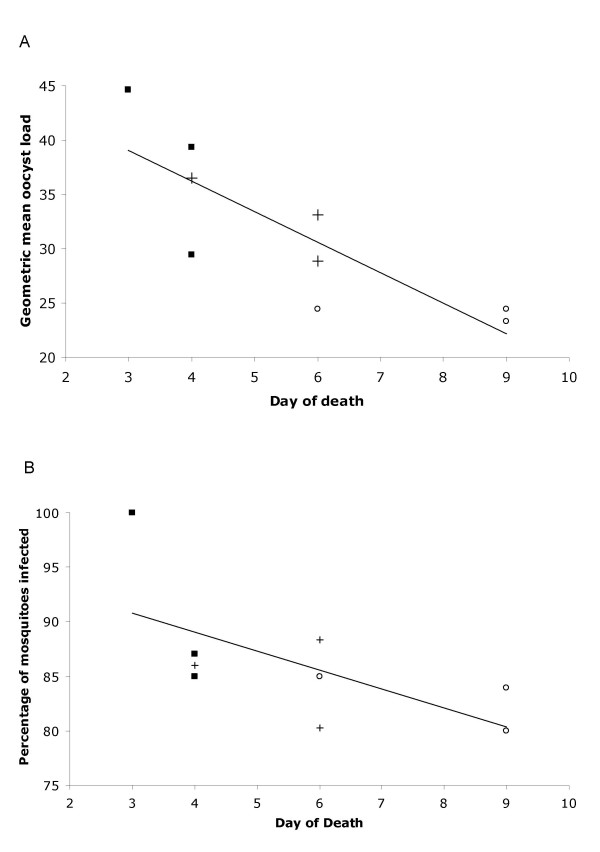
Transmission success as measured by (A) the geometric mean oocyst load per mosquito and (B) the percentage of mosquitoes that were positive for at least one oocyst, related to day of death for the 2 single clone and the mixed clone type infections. Three birds in each group (injected with single or mixed parasite clones as in Figs. 1 & 2) were gorged on mosquitoes on the first day of patent infection. Thai clone (squares); SL clone (open circles); mixed clones (crosses). Line represents least squared residual best fit for the relationship between oocyst load and day of death. (A) R2 = 0.68, P = 0.017; (B) R2 = 0.41, P = 0.032.